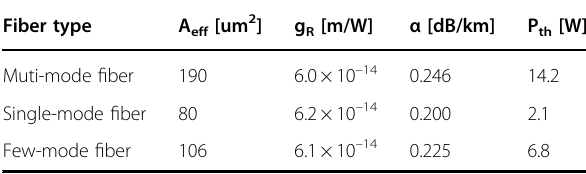
Table 7 Measured parameters of the